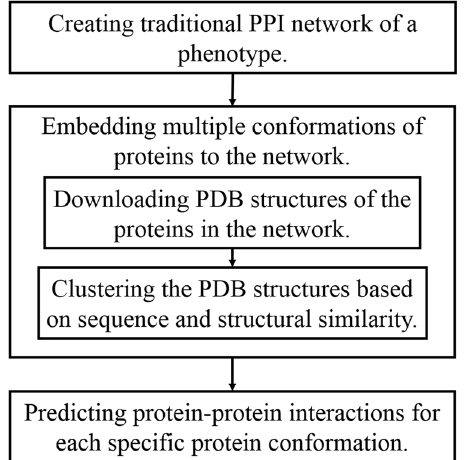
Figure 3. Flowchart of creating the multi-conformational PPI network.